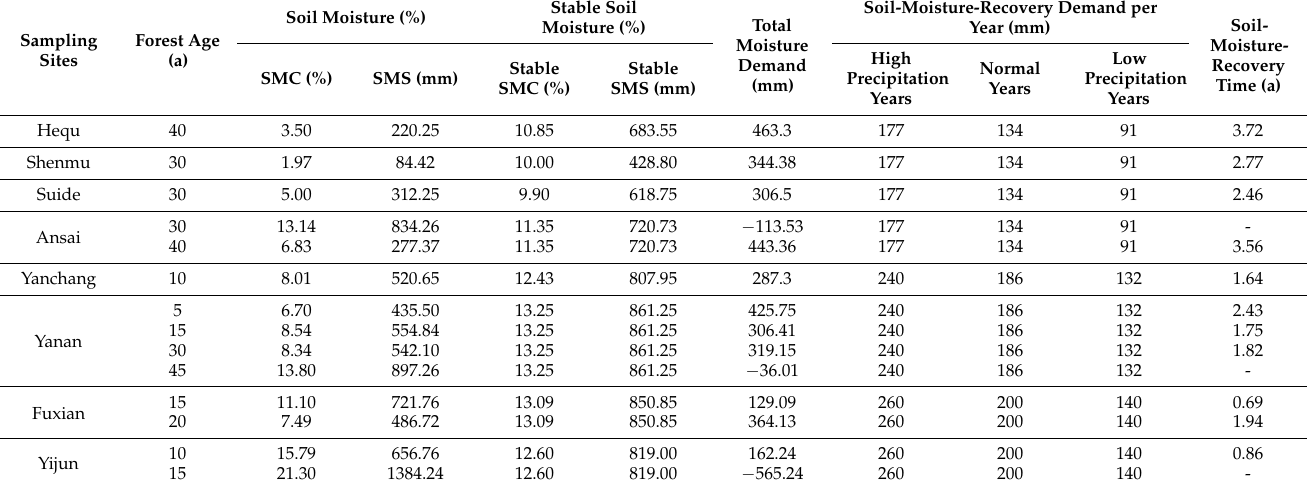
Table 8. Comparison of water demand and time required for soil-moisture recovery under R. pseudoacacia plantations on the Loess Plateau of